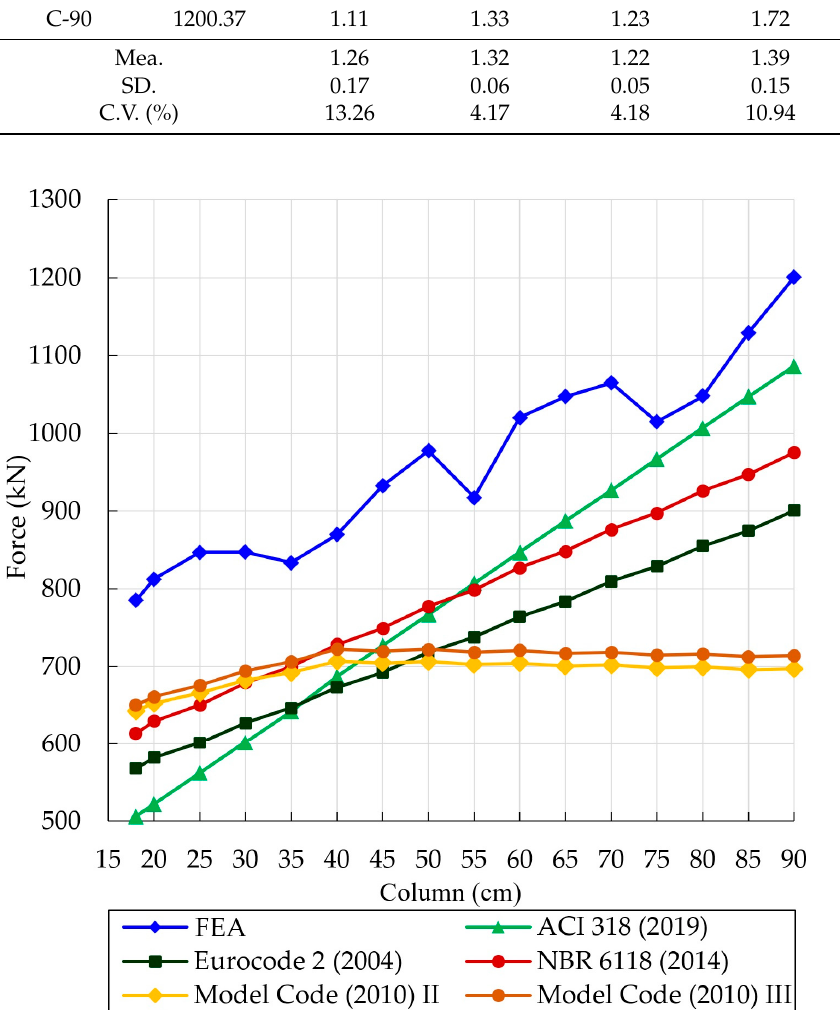
Figure 20. Failure load evolution in relation to the spacing of prestressing tendons (Series C) [11– 14].